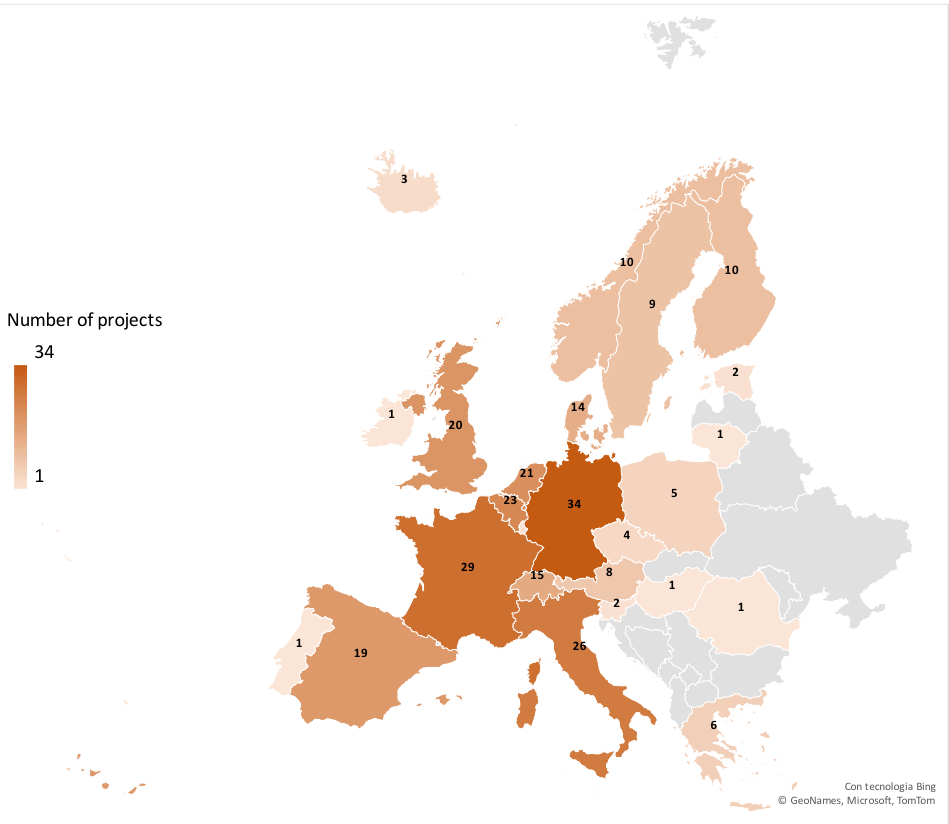
Figure 5. Number of projects per participating country.